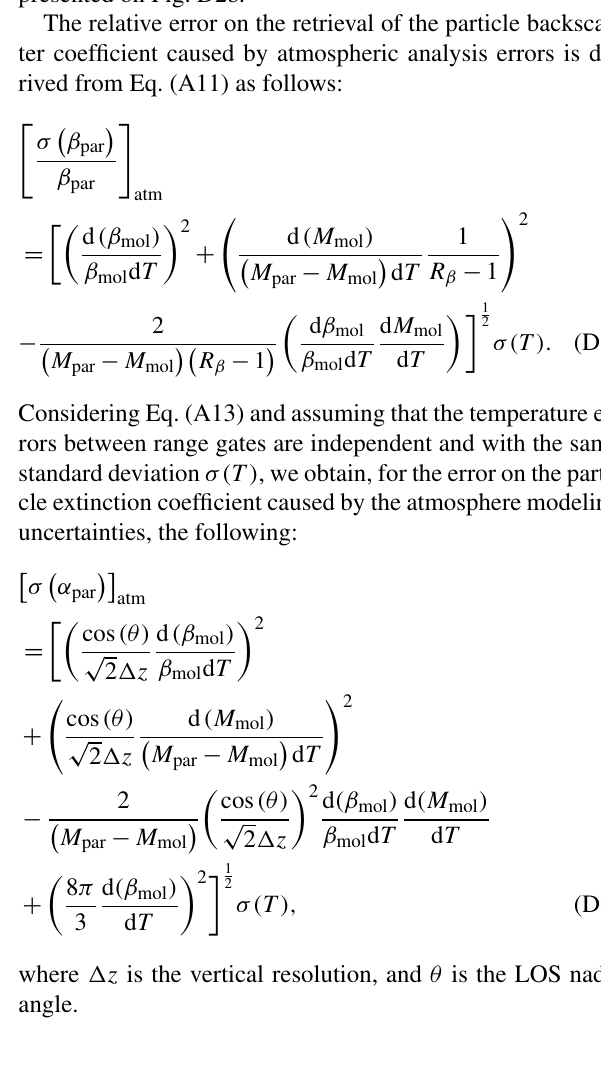
Figure D2. Temperature sensitivity for (a) M mol and (b) β mol as a function of